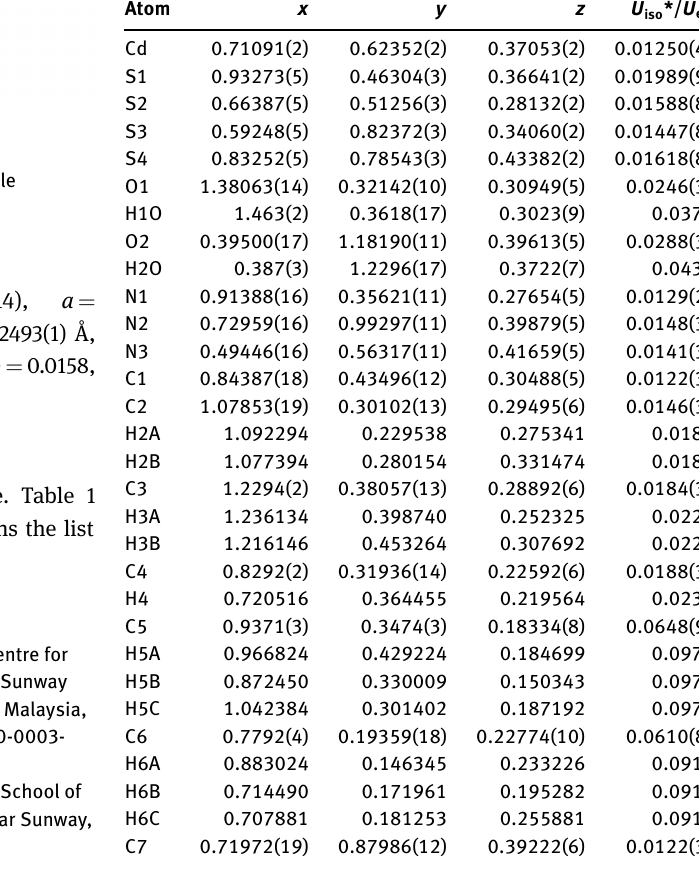
Table 2: Fractional atomic coordinates and isotropic or equivalent isotropic displacement parameters (Å 2